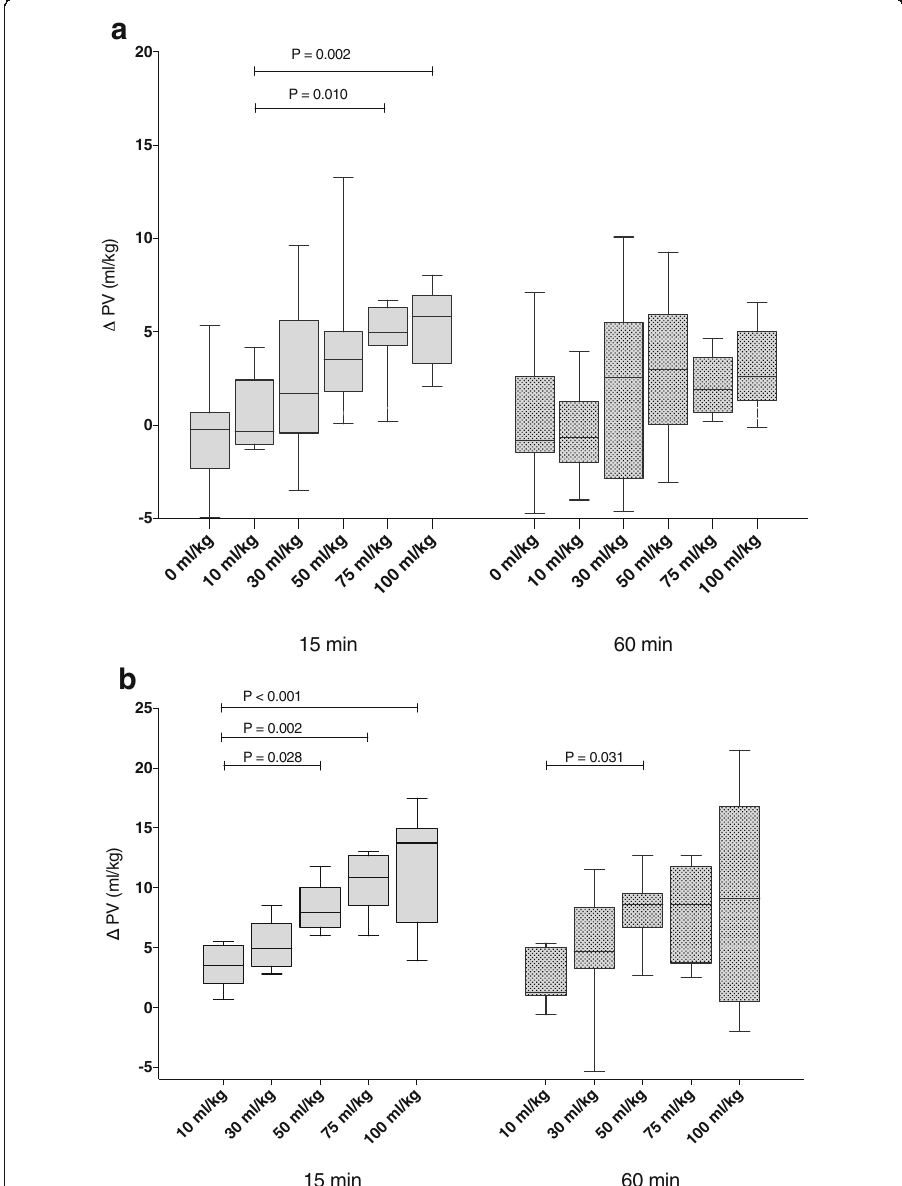
Fig. 4 Change in plasma volume ( Δ PV) in the sepsis and the hemorrhage groups at 15- and at 60 min after completion of fluid resuscitation. Panel a : Change in plasma volume in sepsis groups resuscitated with 10 ml/kg ( n = 9, second bar from the left at each of the time points), 30 ml/kg ( n = 10), 50 ml/kg ( n = 10), 75 ml/kg ( n = 8), 100 ml/kg (n = 8) and in animals not receiving fluid resuscitation ( n = 10, first bar form the left, at each of the time points). b panel: Change in plasma volumes in hemorrhage groups resuscitated with 10 ml/kg ( n = 7), 30 ml/kg ( n = 8), 50 ml/kg ( n = 8), 75 ml/kg ( n = 8) and 100 ml/kg ( n = 8) (* = P < 0.05). Data analyzed using one-way ANOVA on ranks and multiple comparisons were adjusted using the Dunn ’ s Plasma oncotic pressure In the sepsis and hemorrhage groups resuscitated with 10 ml/kg plasma oncotic pressures at 60 min after resuscitation were 14.8 (14.4 – 15.5) mmHg and 11.7 (11.0 – 12.7) mmHg, respectively, (Fig. 5). There was a dose-dependent decrease in colloid osmotic pressure in both conditions, which was more marked in sepsis than